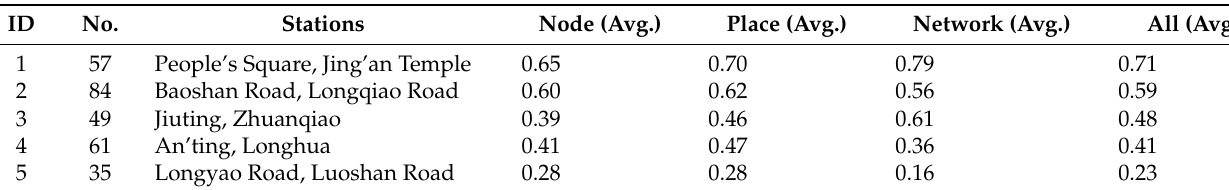
Table 6. Description summary of the five clusters.